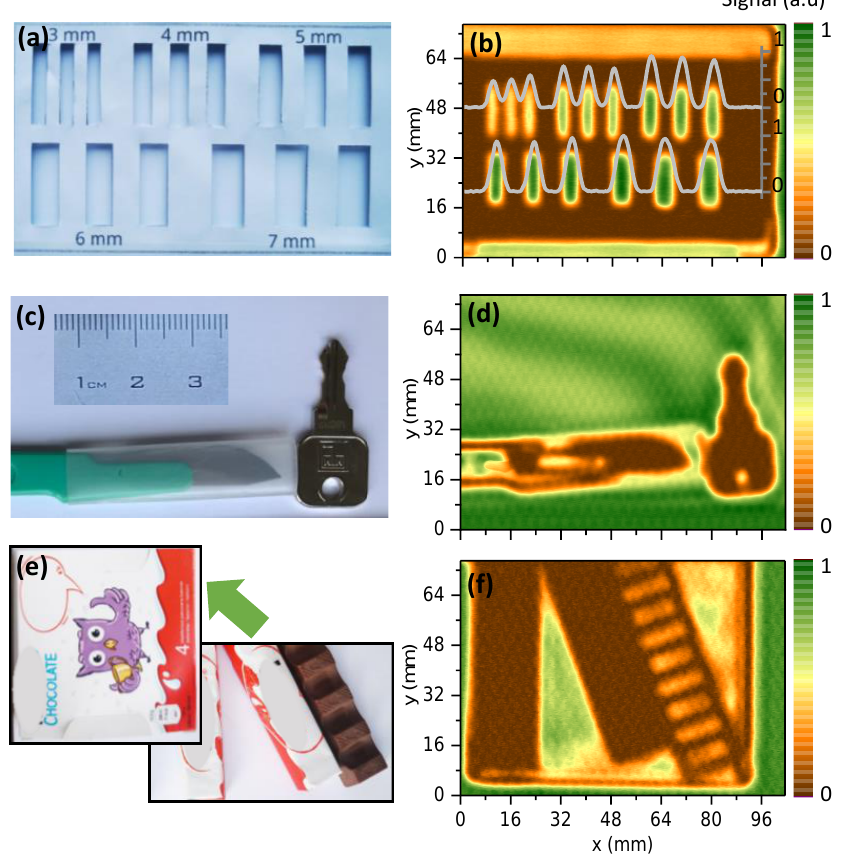
Figure 7. Photos ( a , c , e ) of several objects and their 94 GHz images ( b , d , f ), obtained using the prototype low-cost imaging system in the transmission mode of operation. The chocolate image exhibits a contrast of about 30; the knife image contrast reaches about 50, while that of the target amounts to 80; all the values were averaged from at least 1500